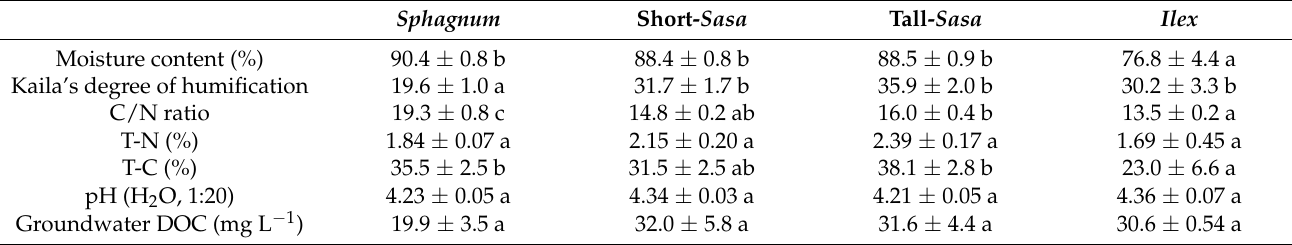
Table 2. Physico-chemical properties of surface peat layer (0–10 cm) and ground water dissolved organic carbon (DOC) at flux measurement plots. Sphagnum Short- Sasa Tall- Sasa